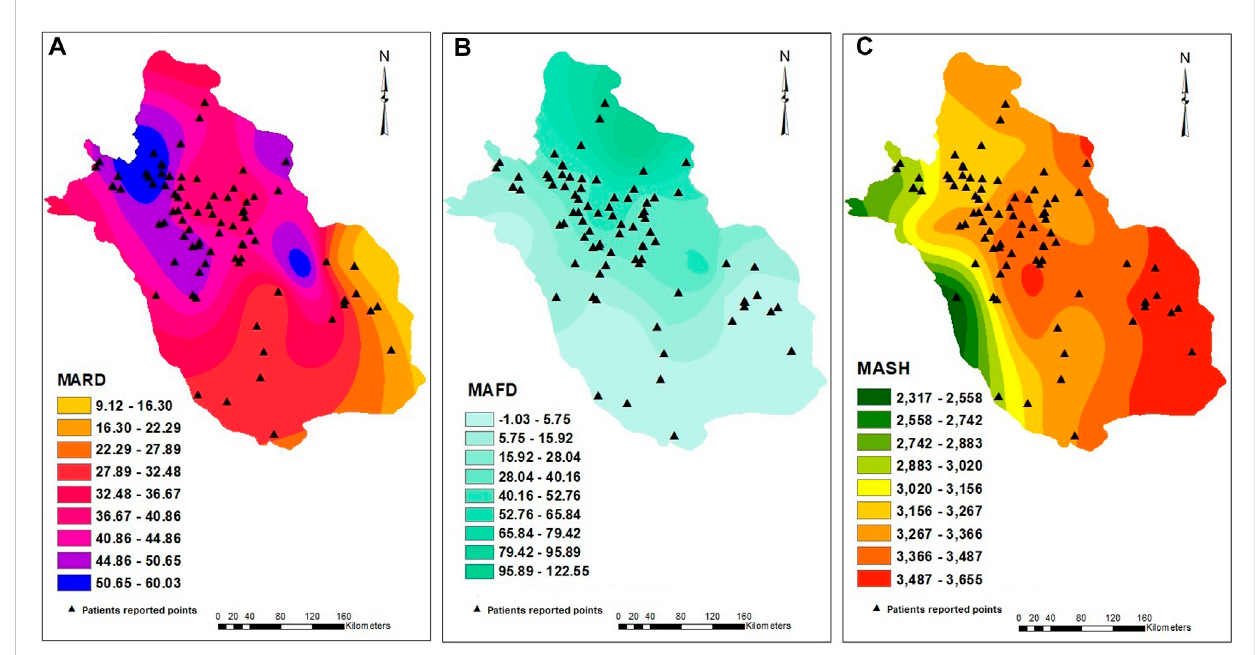
FIGURE 4 Points with acute adult asthma (triangle symbol) located in areas with varied range of MARD (A) , MAFD (B) , and MASH (C) .